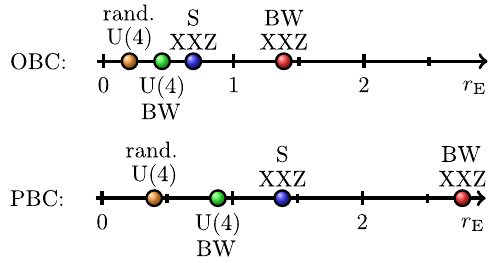
for FIG. 2. Illustration of different quantum circuit configurations E (here, for OBC): (a) brick-wall (BW) configuration and (b) stair- case (S)